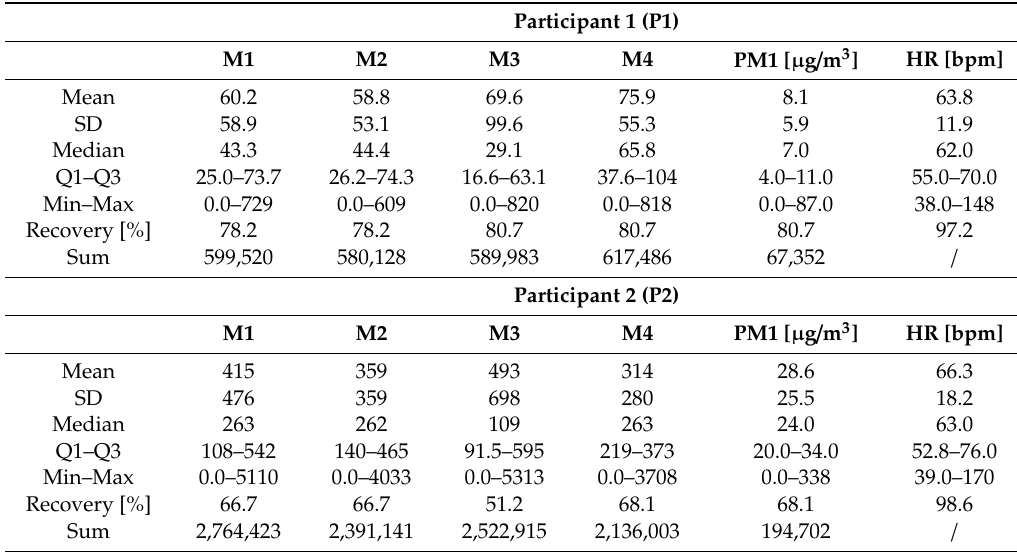
Table 4. Descriptive statistics for intake dose assessments based on all four models, PM 1 concentrations, and heart rate (HR) values for both participants. Recovery represents the percent of data recovered, where 100% is the entire period of observation. Sum represents the accumulated dose for the entire week of observation.